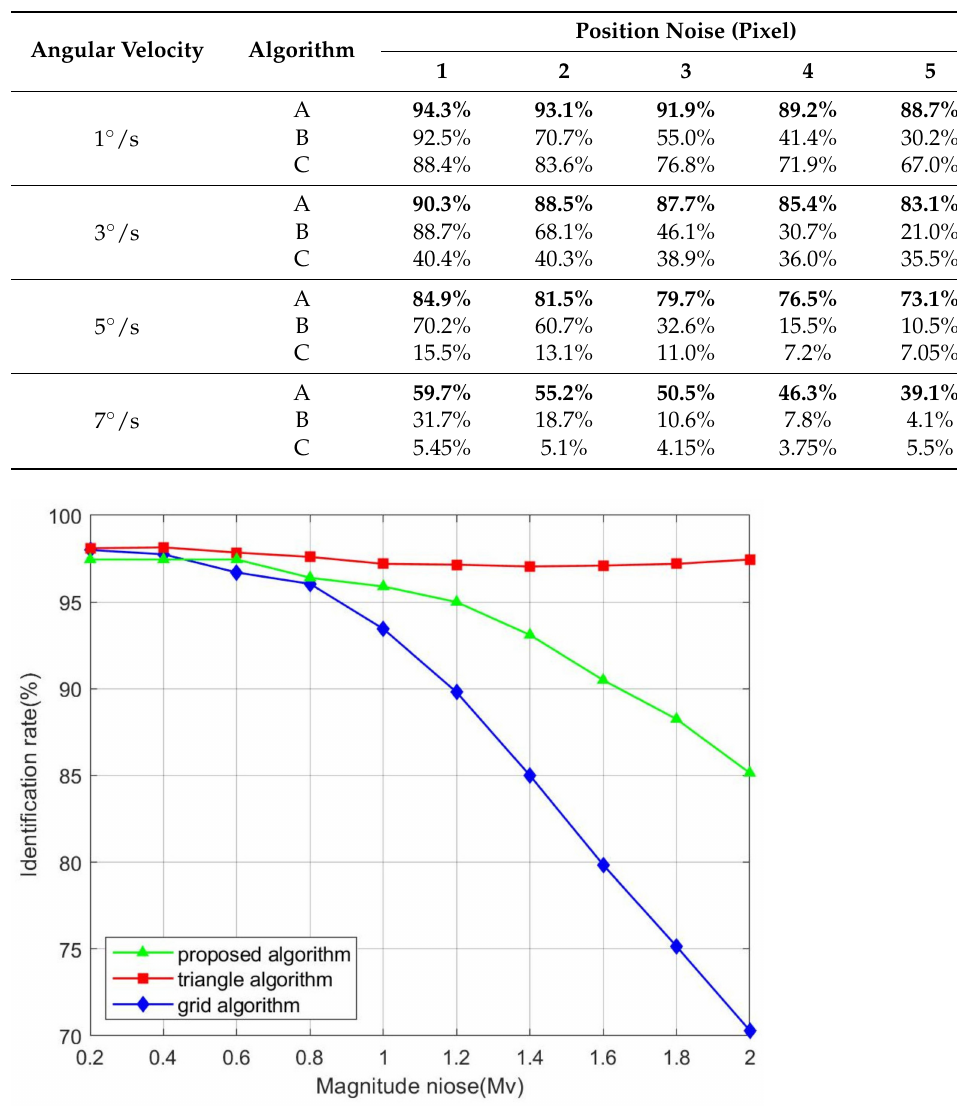
Table 2. Identification rate of different position noise.